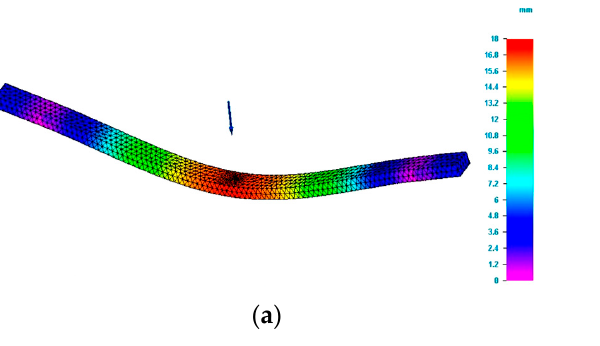
( b ) Figure 6. Result of simulation process for G_R5 specimen (total deformation values). ( a ) Total de- formation values for simple modelling. ( b ) Total deformation values for complex modelling.